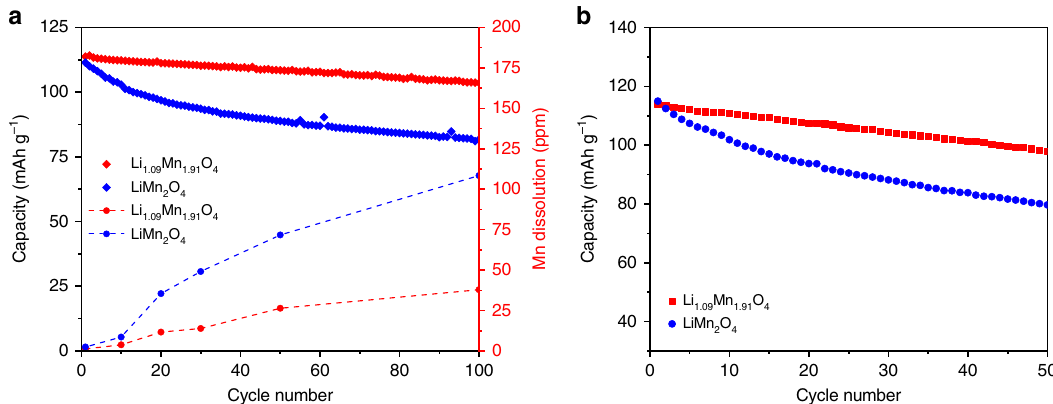
Fig. 4 Mn dissolution analysis and cycling performances in half-cell and full cell. a Cycle performance of Li/LiMn 2 O 4 half-cell (point curve) and concentration of Mn deposited on Li anodes harvested after different charge – discharge cycles (point-line curve). b The cycle performance was tested in Graphite/LiMn 2 O 4 full cell (point curve) at 0.1C